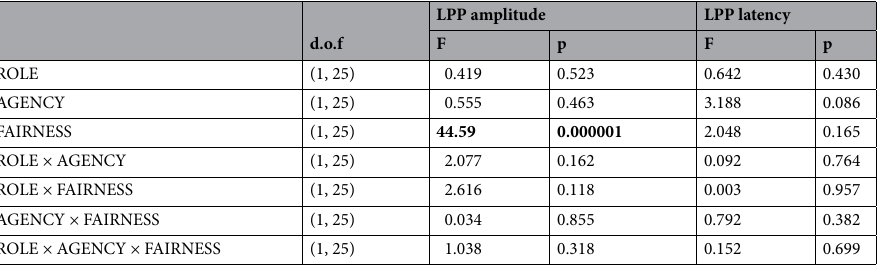
Table 1. Results of the mixed ANOVA computed considering as within factors the agency (AGENCY: Agent, PC) and the fairness (FAIRNESS: fair, hyperunfair), as between factor the players’ role (ROLE: receiver, observer) and as dependent variables the LPP amplitude and latency, separately. Significant values are in bold.